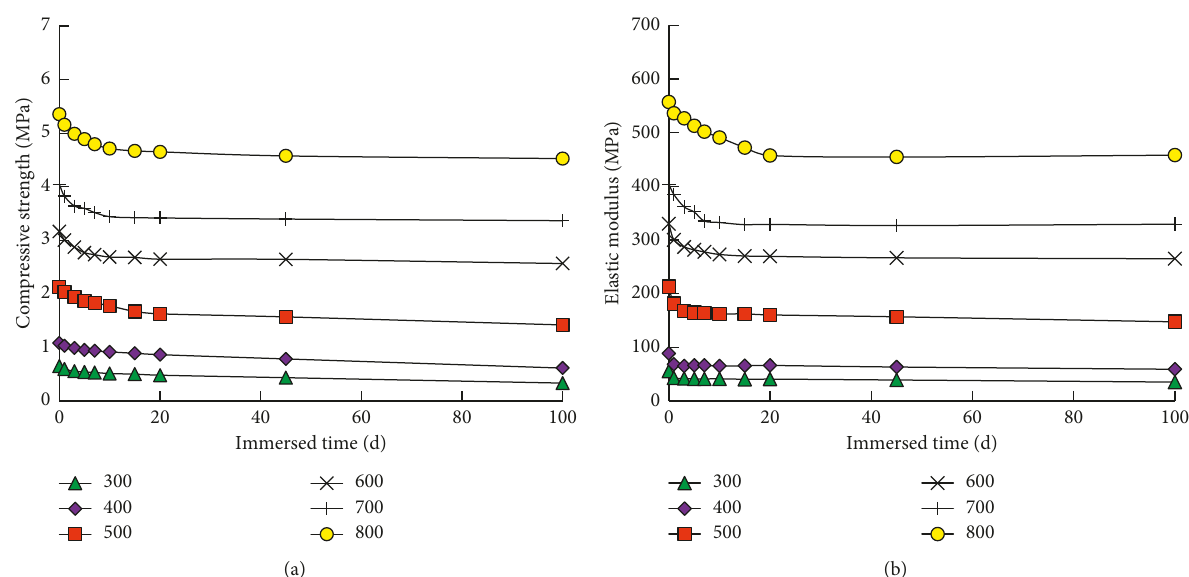
Figure 12: Effect of immersion time on (a) compressive strength and (b) elastic modulus (the water-level changed condition).